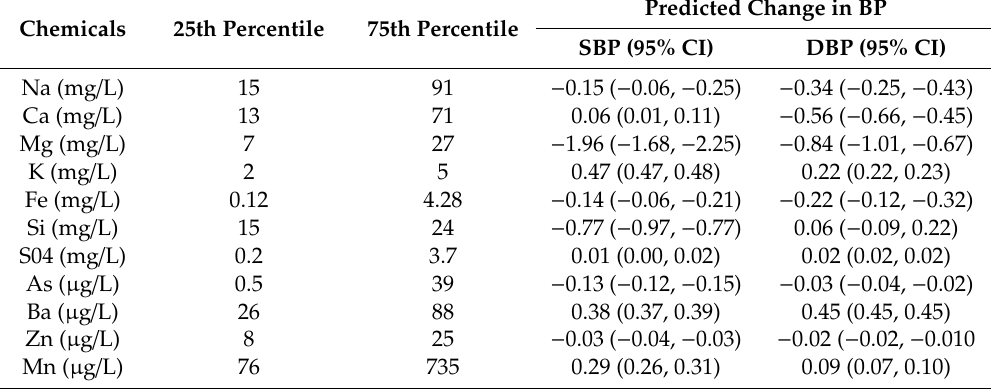
Table 2. Prediction of change in systolic blood pressure (SBP) and diastolic blood pressure (DBP) when chemicals increased from the 25th percentile to the 75th percentile distribution. Predictions were done for non-smoker females from Barisal region who were from the lowest wealth quintile and had no institutional education, and whose age, BMI and all other chemical concentrations were set at mean values.